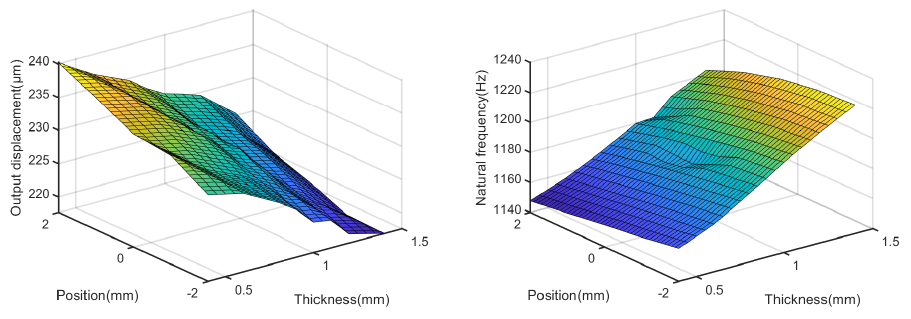
Figure 10. Effects of t c and l 3 on the output displacement and natural